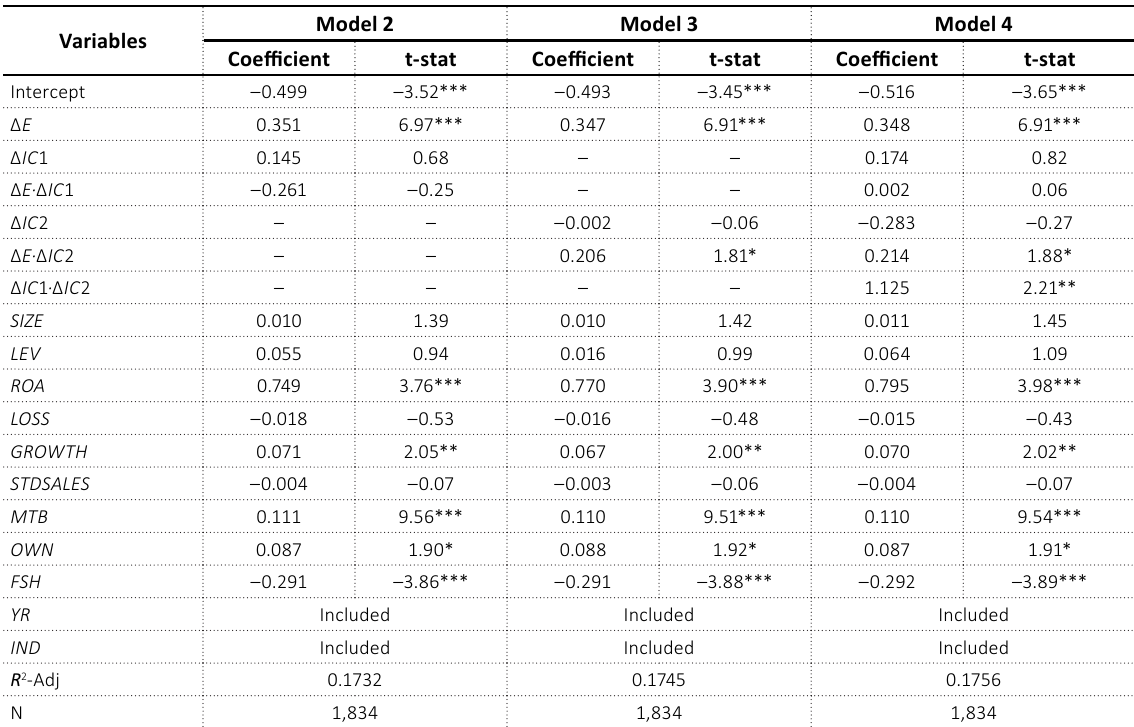
Table 7. Additional analysis on the effect of IC environment on the value relevance of earnings using modified